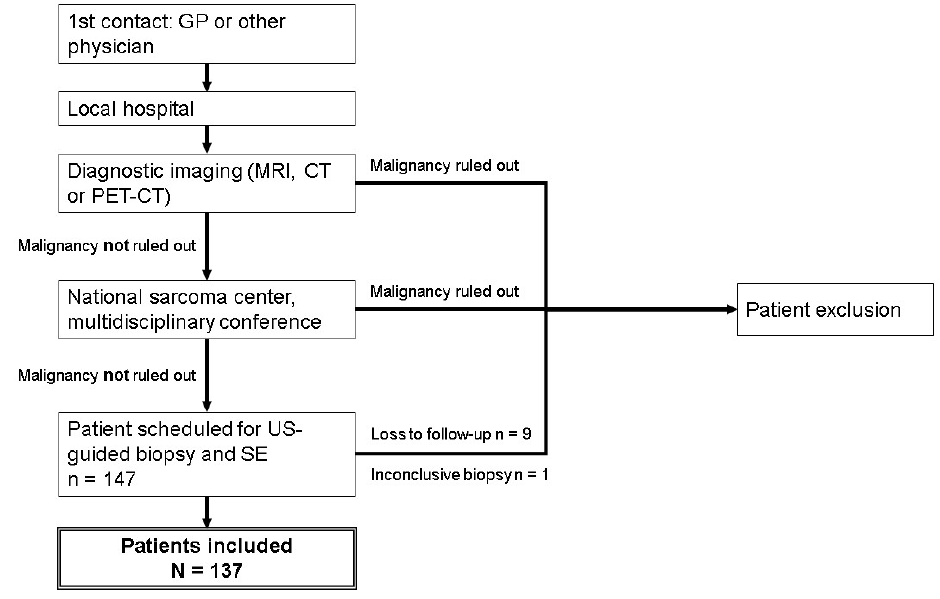
Figure 1. Patient inclusion. In total, 147 patients were screened for inclusion. Nine patients were lost to follow-up, and one patient had an inconclusive biopsy leading to exclusion. A total of 137 patients were included.